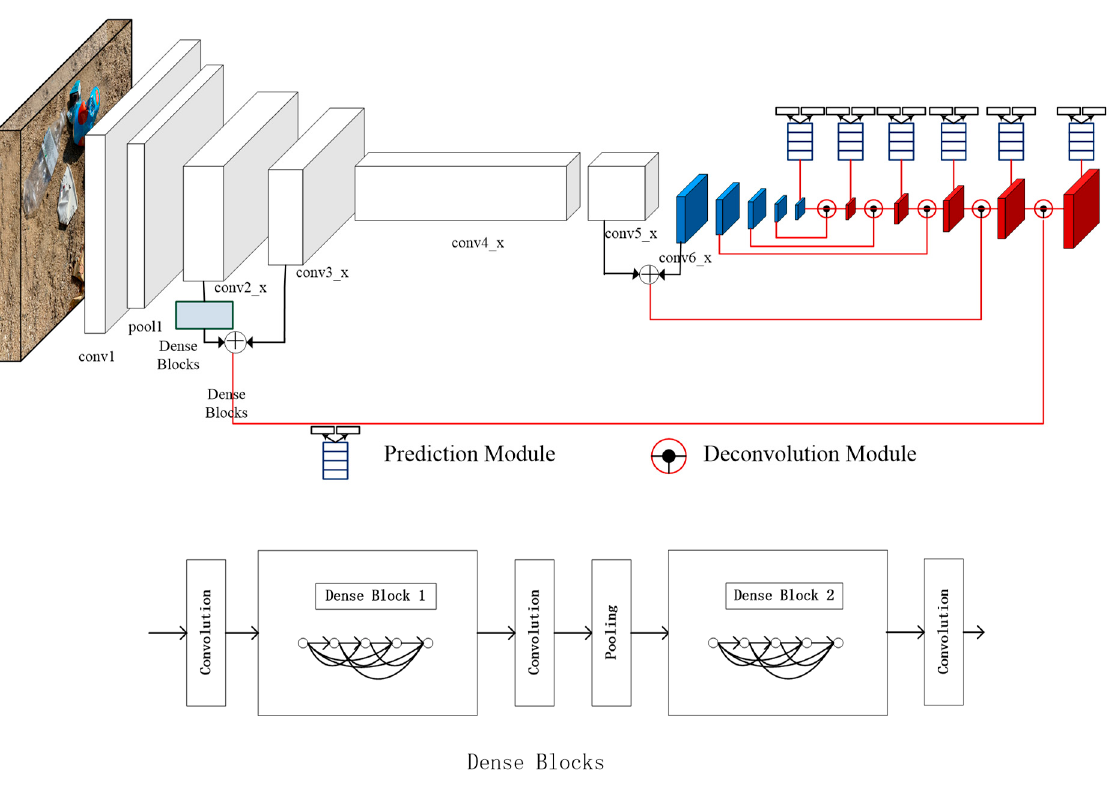
Figure 4. The structure of MS-DSSD .